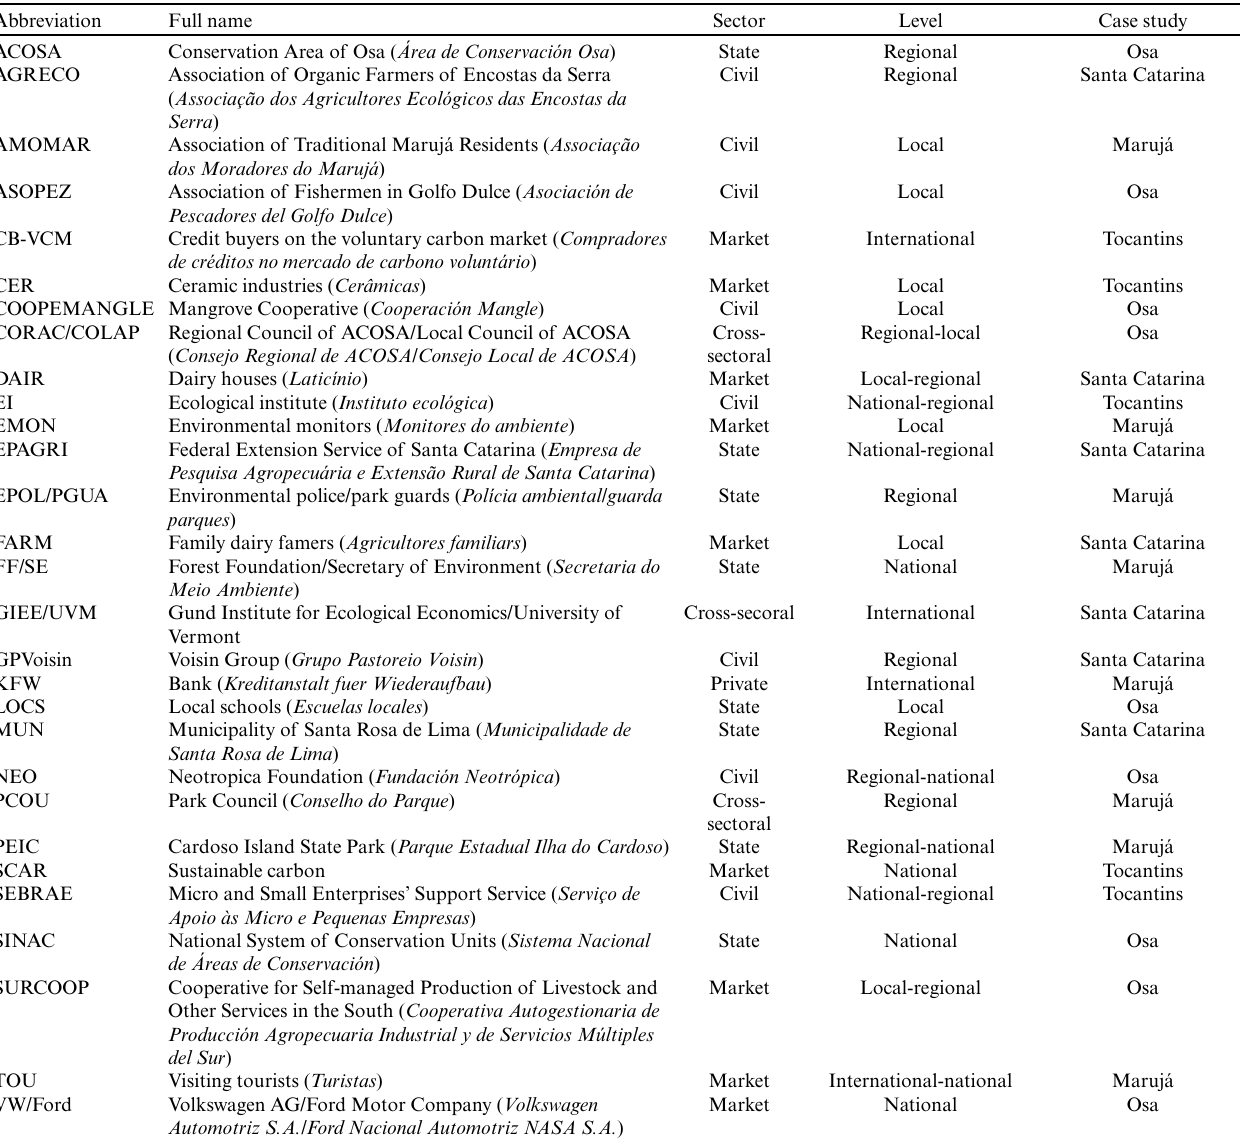
Table 3. Abbreviations, full names, and attribute data for all